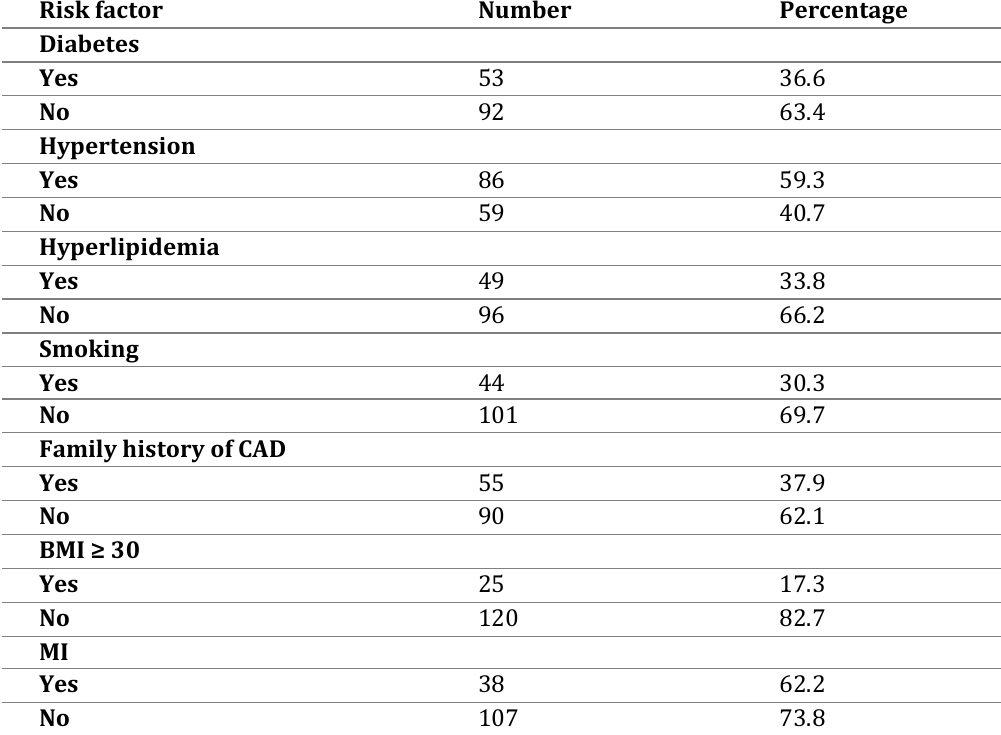
Table 1 : Frequency distribution of coronary artery disease (CAD) risk